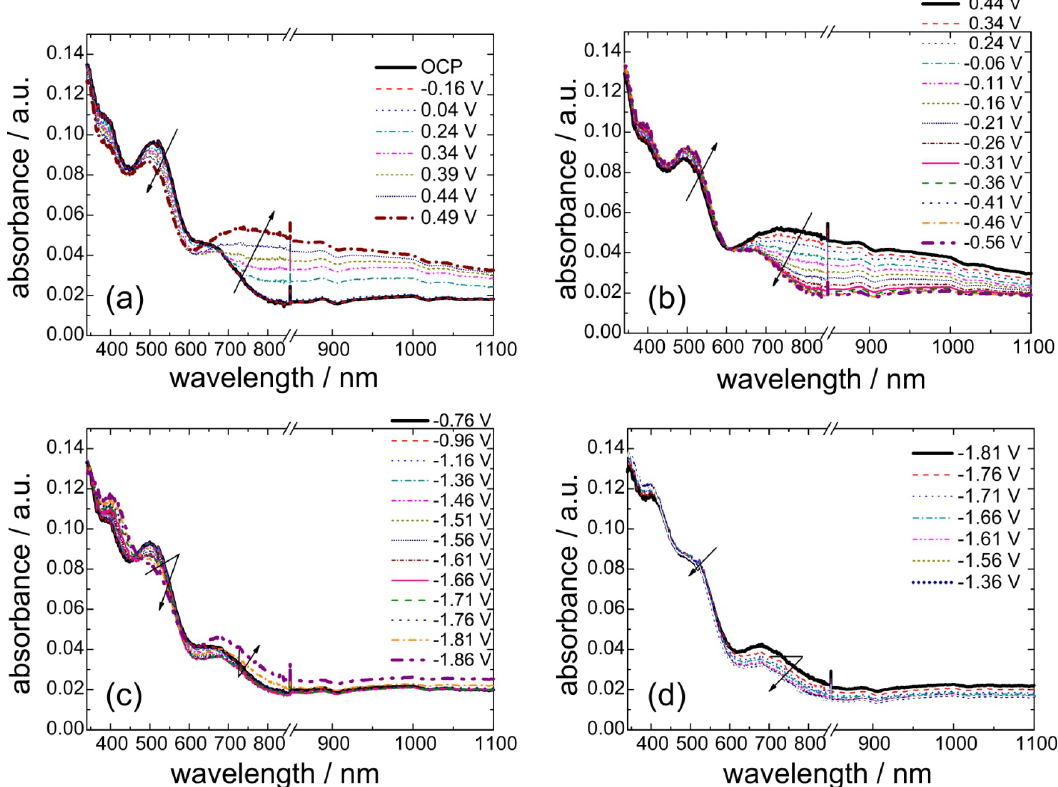
Figure 6. Spectroelectrochemistry in different potential regions of a poly(DEHT-V-BTD) film prepared by PPS: ( a ) oxidation of the neutral polymer; ( b ) reduction of the oxidized polymer; ( c ) reduction of the neutral polymer; and ( d ) oxidation of the reduced polymer. OCP refers to the open circuit potential